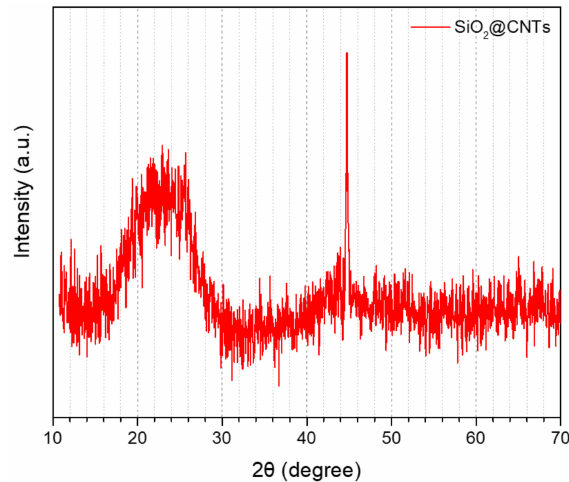
Figure 6. XRD spectrum of SiO 2